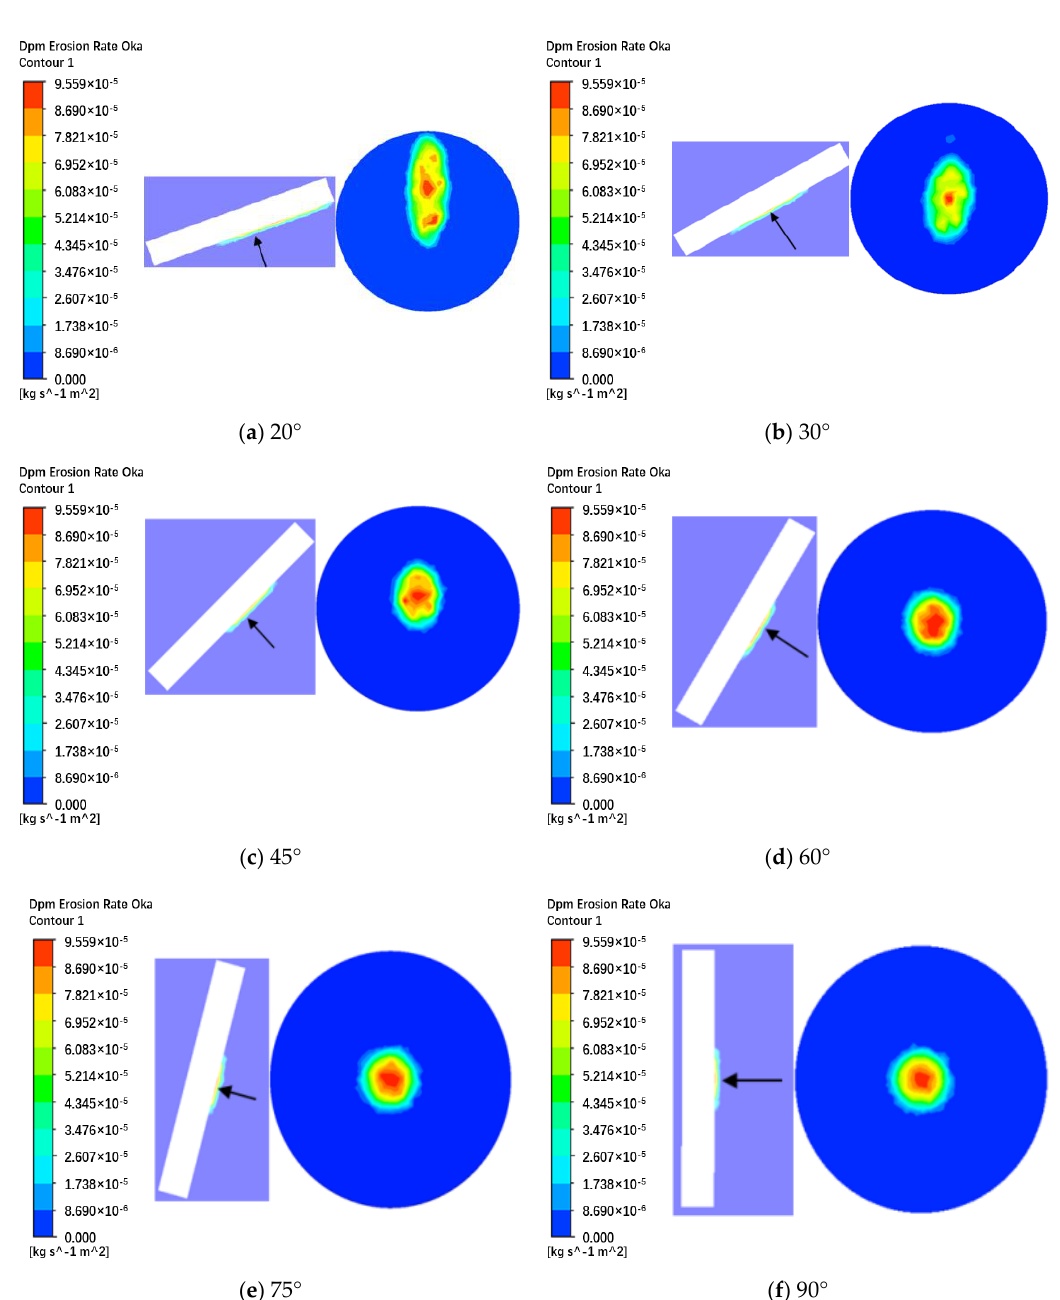
Figure 11. A comparison of the erosion nephogram results at different impact angles ( v g = 60 m/s, v p = 19 m/s, and d p = 300 μm). ( a ) 20° impact erosion nephogram. ( b ) 20° impact erosion nephogram. ( c ) 20° impact erosion nephogram. ( d ) 20° impact erosion nephogram. ( e ) 20° impact erosion nephogram. ( f ) 20° impact erosion nephogram.